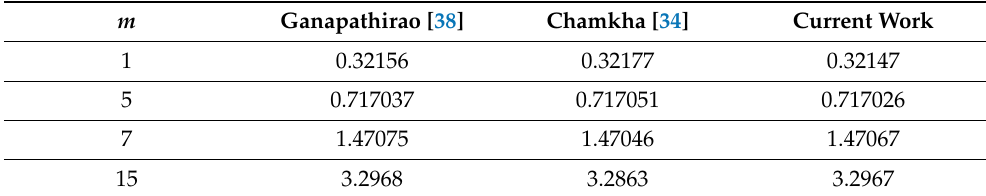
Table 3. Assessment of the coefficient of Nusselt number for numerous values of Pr when M = K = Rd = Ec = λ = γ = δ =